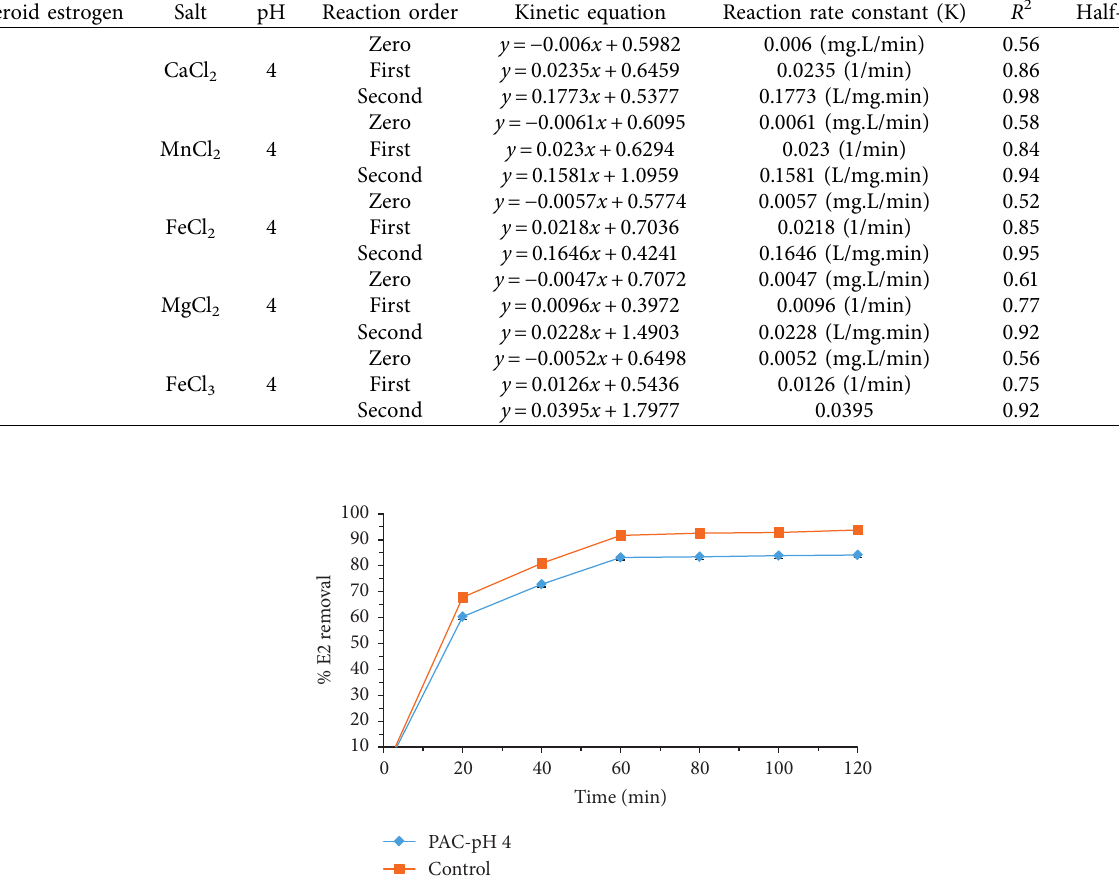
Figure 3: Removal percentage of E2 in the presence of PAC for optimum pH. Table 4: Degradation kinetic parameters of E2 in presence of PAC for optimum pH. Steroid